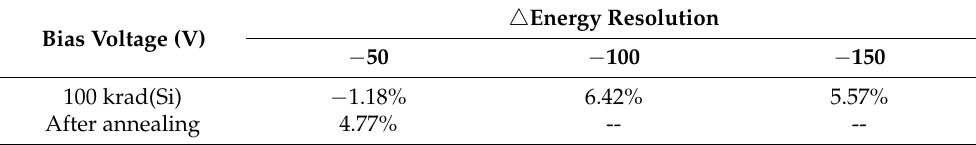
Table 1. Total dose response of the CsPbBr3 detectors under different test